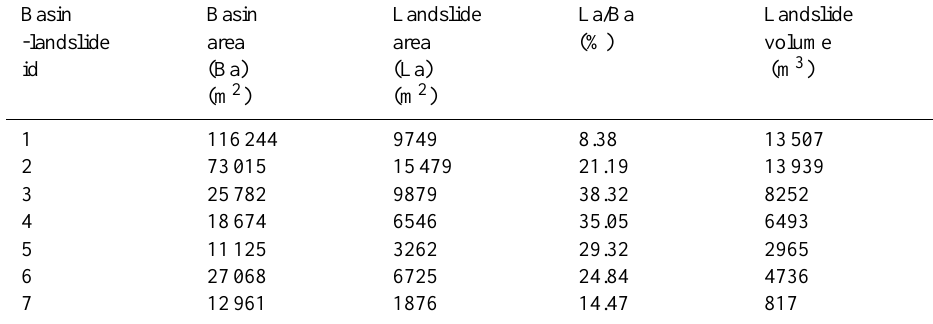
Table 1. Volume and area (La/Ba) estimations for each landslide. Landslides volume was estimated using pre-event and post-event DEM.